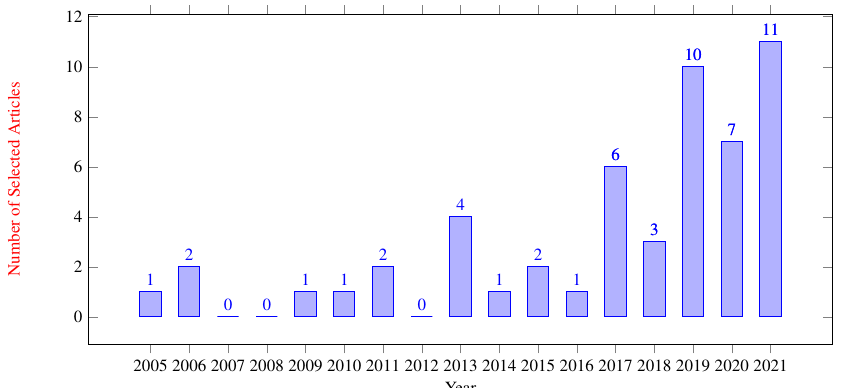
Figure 3. Year of publication.